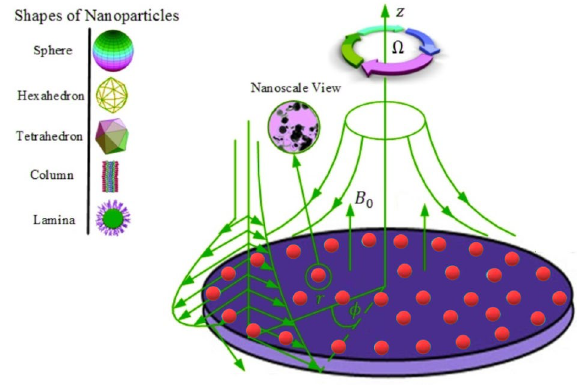
Figure 1. Flow geometry of considered